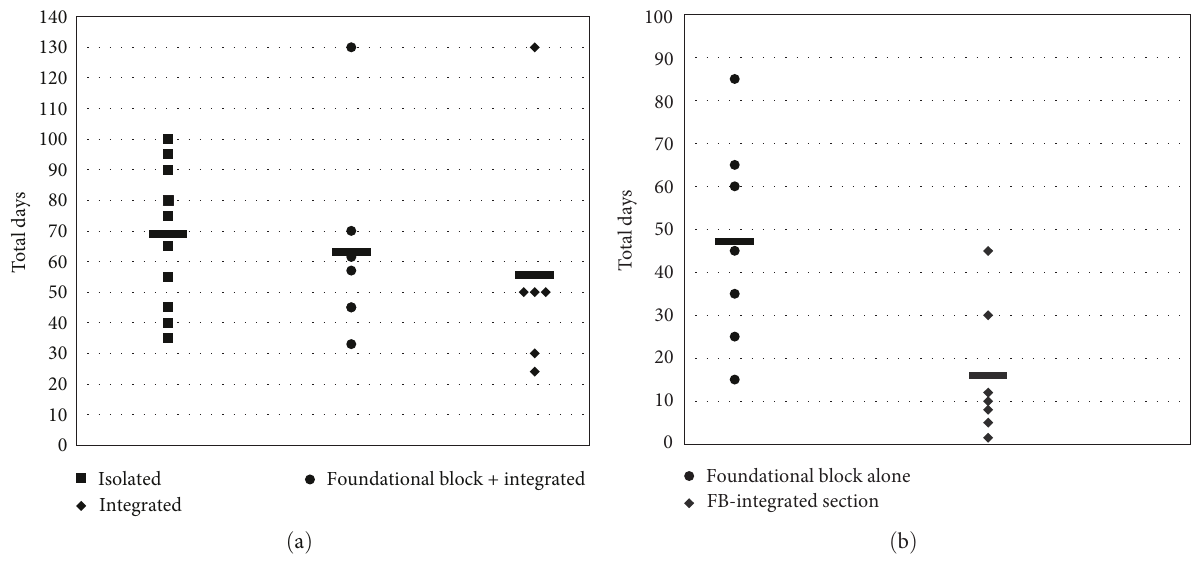
F IGURE 1: (a) Estimated total number of days of anatomy by curriculum type. Bar indicates the mean; (b) Estimated total number of days of anatomy in the foundational block and integrated sections of the foundational block plus integrated format,